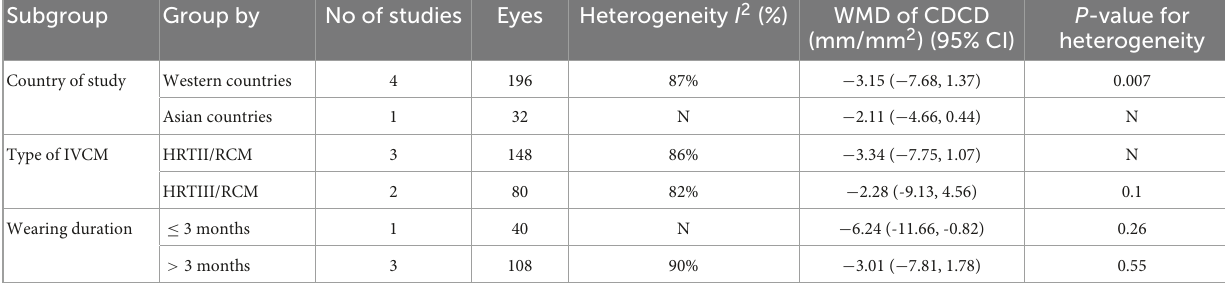
TABLE 2 Subgroup meta-analysis of